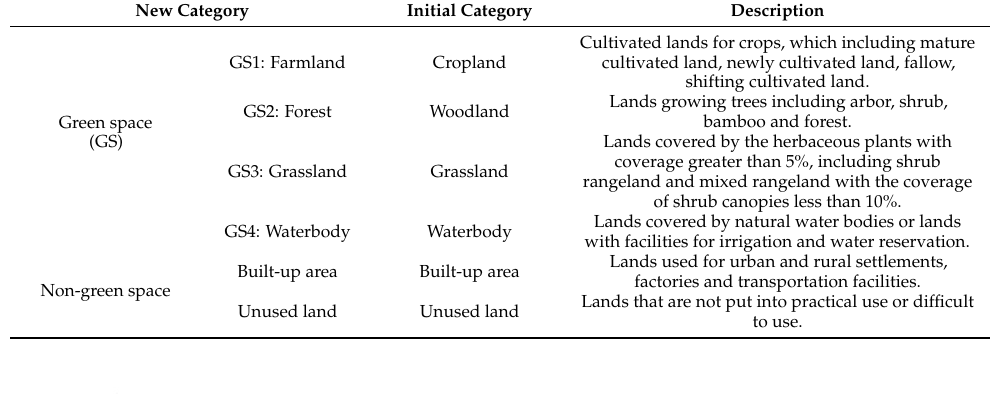
Table 1. The land-use classification criteria applied in this study [42].